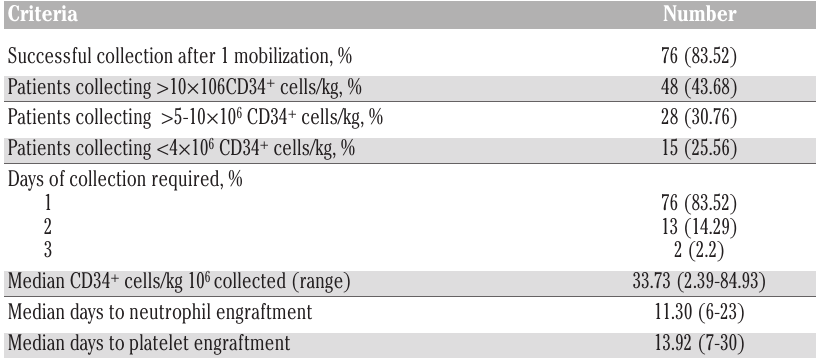
Table 2. Mobilization